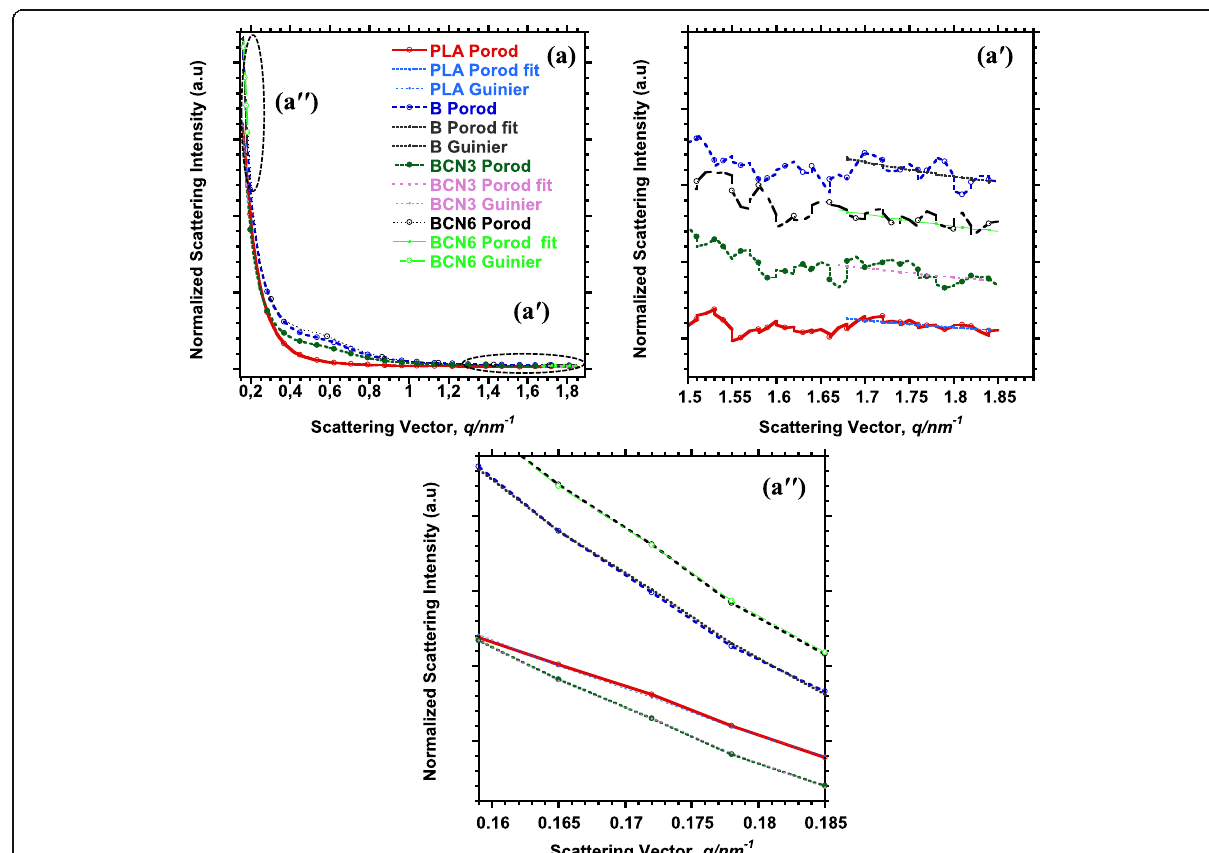
Fig. 3 Normalized scattering intensity plotted against the scattering vector. (a ′ ) Zoomed Porod region and Porod fits and (a ′′ ) Zoomed Guinier region and Guinier fits